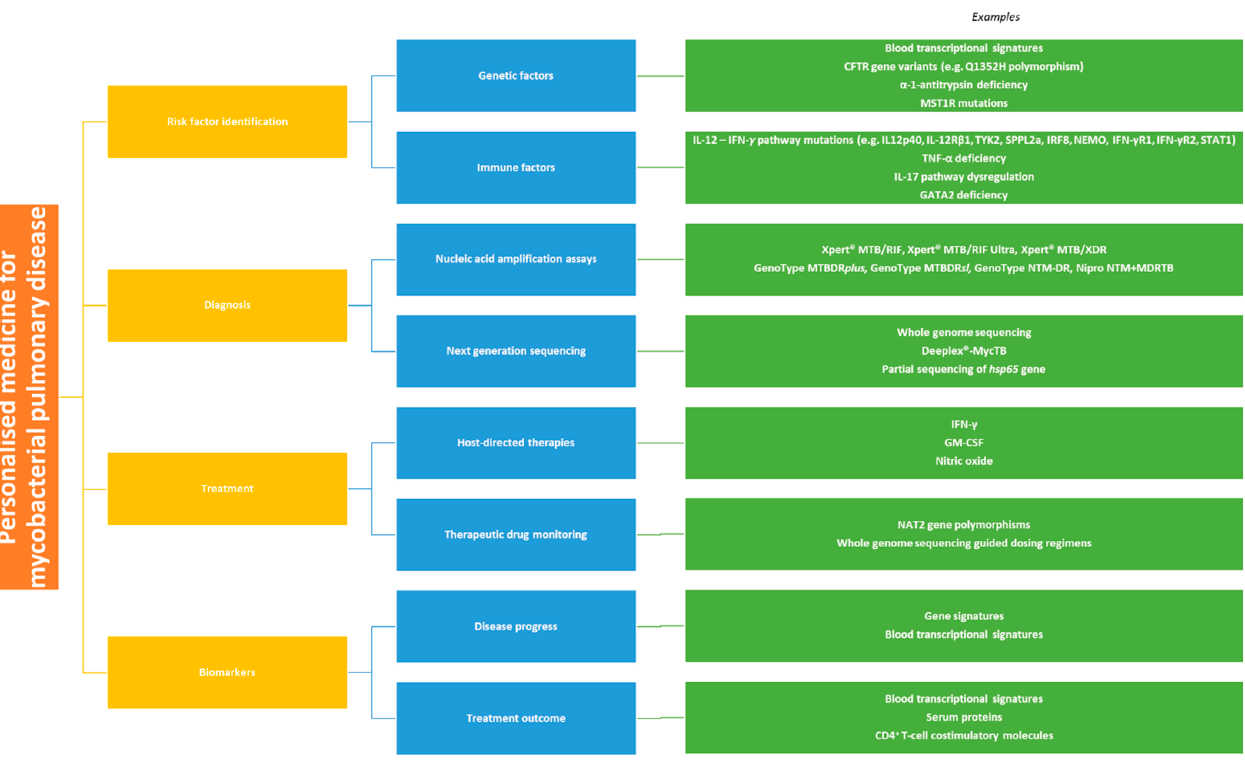
Figure 1. Personalised medicine approaches for the management of mycobacterial pulmonary disease.